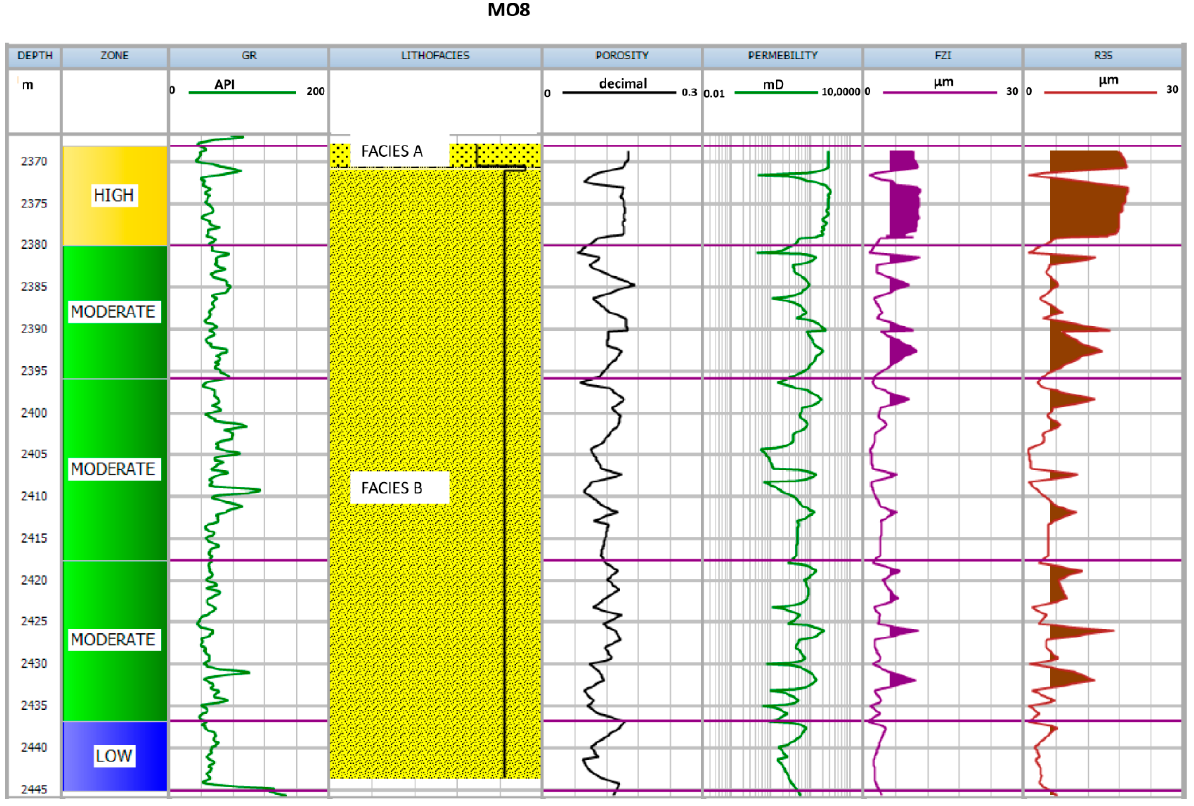
Figure 7. Results of well MO8 showing flow zones in track 2, gamma ray log in track 3, facies in track 4, porosity in track 5, permeability in track 6, FZI in track 7 and r35 in track 8. Six flow zones were identified in well MO9 (Figure 8). At the top of the reservoir is the high flow zone (2369.2–2376.2 m), Low (2376.2–2387.2 m), High (2387.3–2393.3 m), Moderate (2387.3–2419.3 m), High (2419.3–2428.2 m) and Tight (2428.2–2442.4 m) at